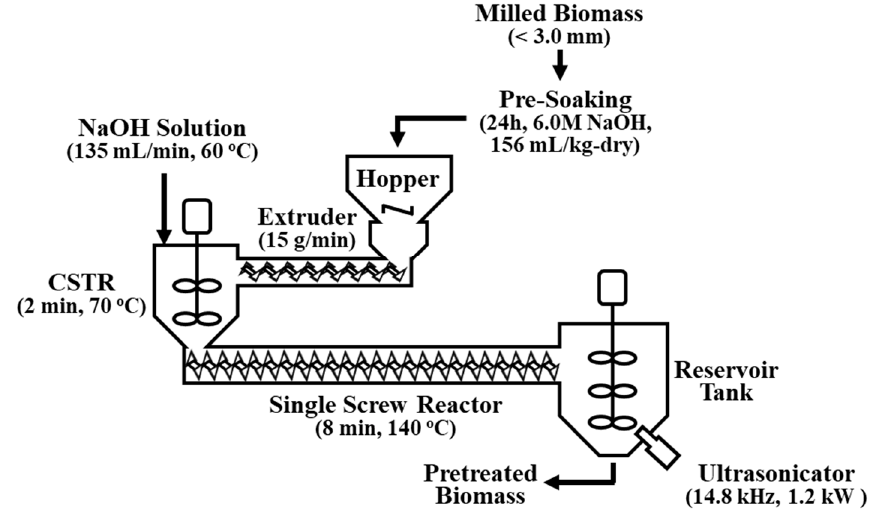
Figure 1. Schematic of the ultrasonication-assisted single-screw alkaline pretreatment system modified from Cha et al. (2015) (CSTR: continuous stirred tank reactor).